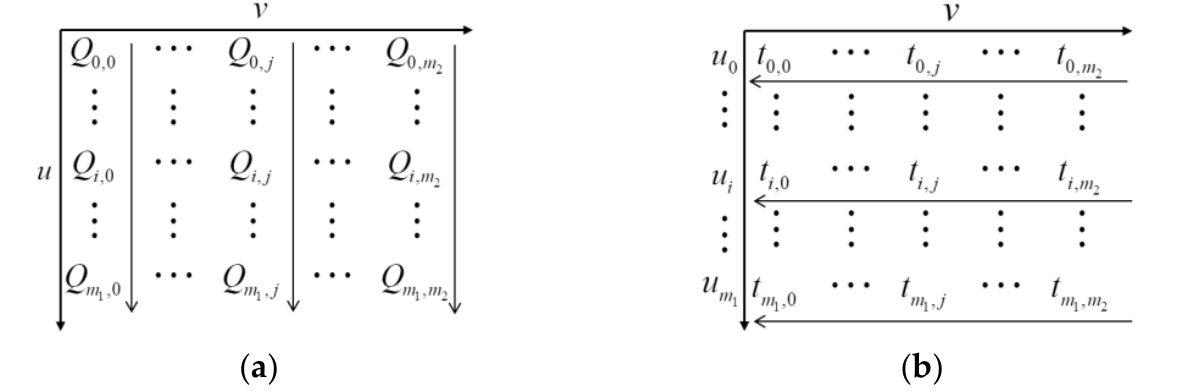
Figure 1. ( a ) u -direction and the v -direction, ( b ) row parameter u i